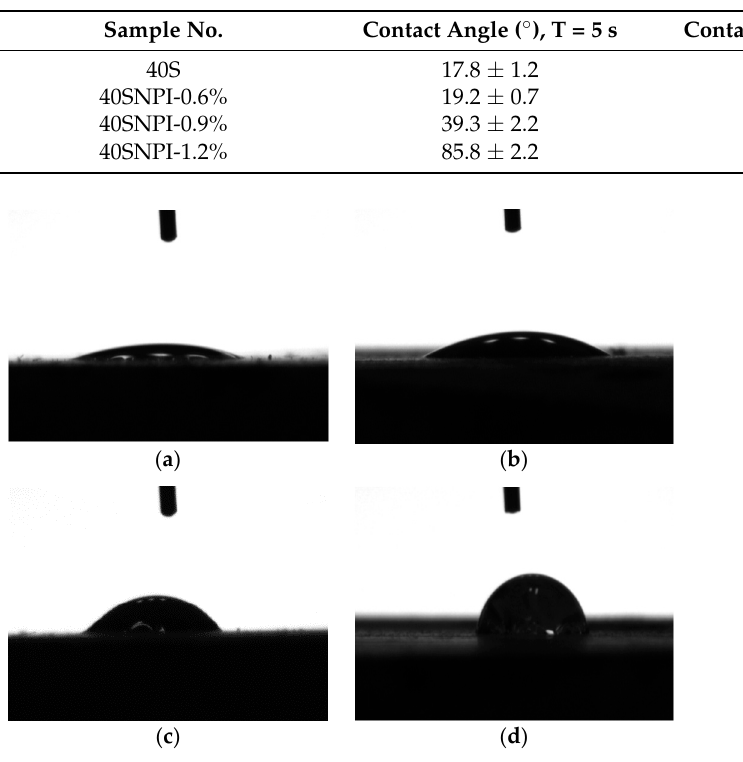
Figure 10. Images of the contact angle of cement pastes with 0% ( a ), 0.6% ( b ), 0.9% ( c ), and 1.2% NPI ( d ). Table 5. Contact angle of cement